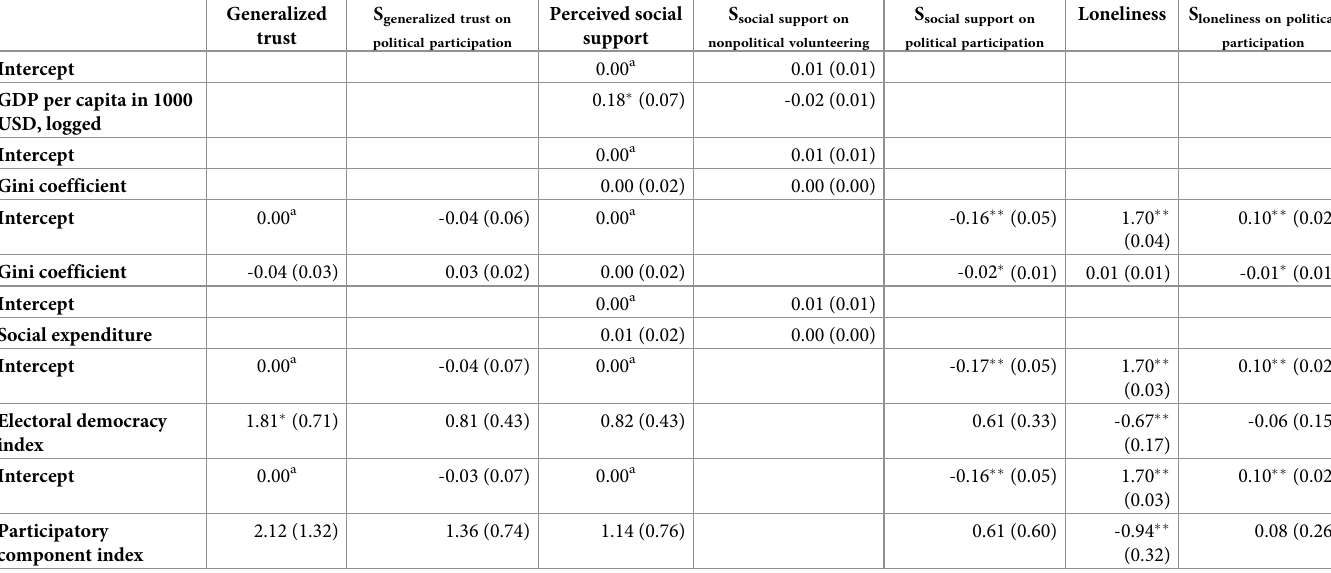
Table 8. Country-level effects of contextual variables on social well-being and cross-level interactions with voluntary participation. Generalized